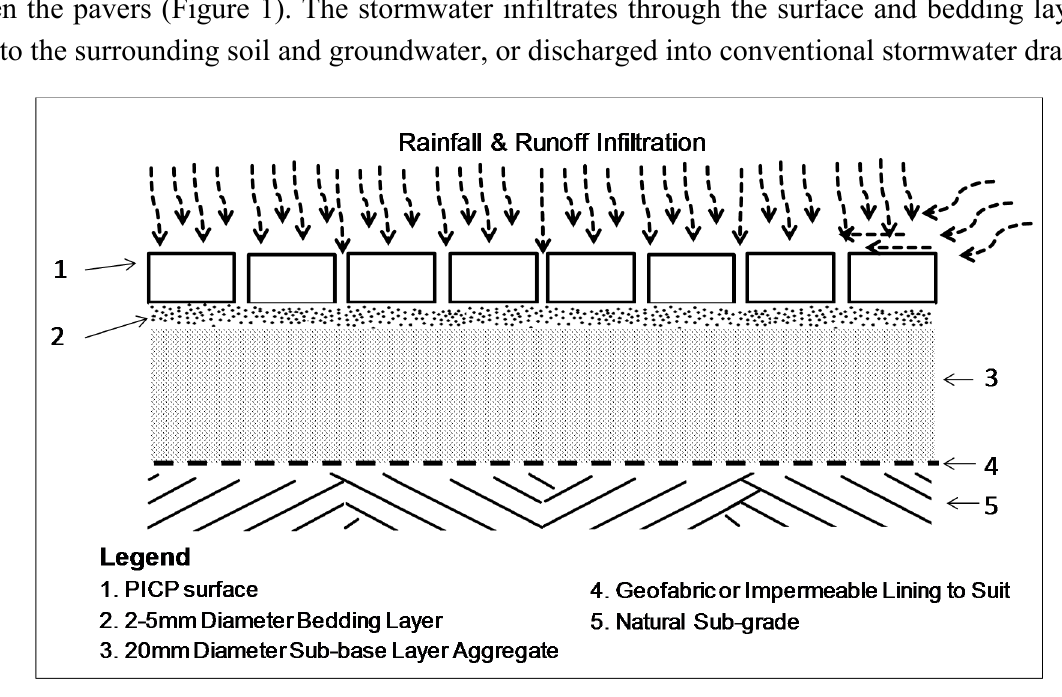
Figure 1. Typical Permeable Interlocking Concrete Pavement (PICP)